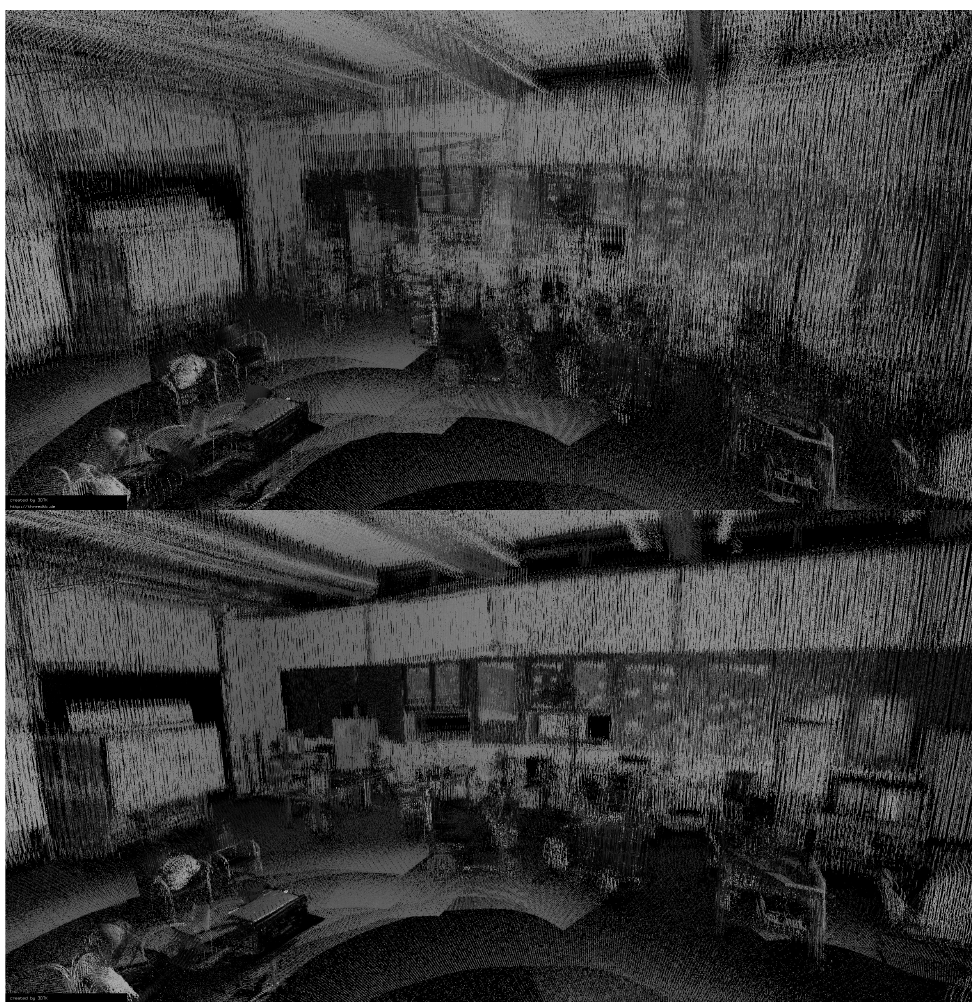
Figure 8. 3D point cloud of Experiment 1 with reflectance values. The quality improves, but the contours are still not sharp after